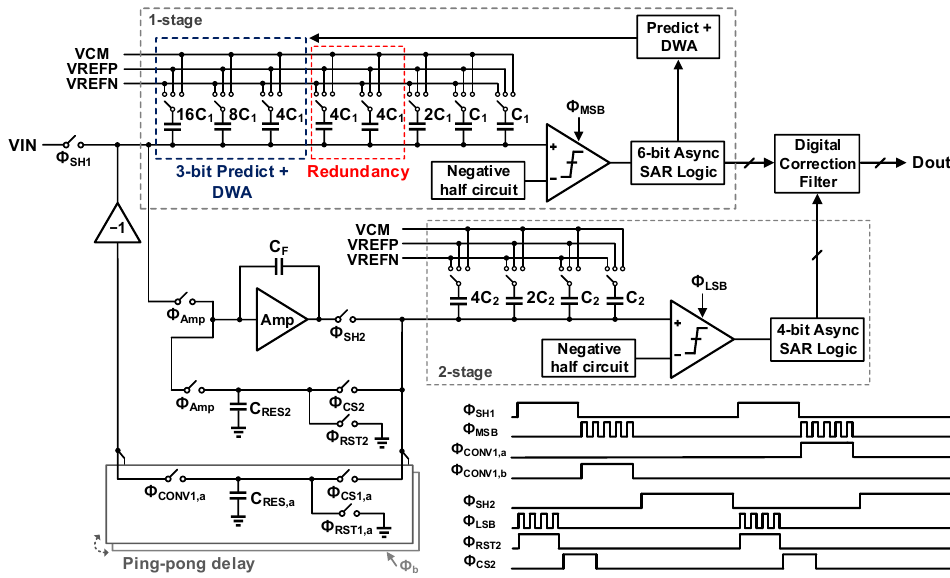
Figure 5. Circuit implementation of proposed PLNS-SAR ADC.